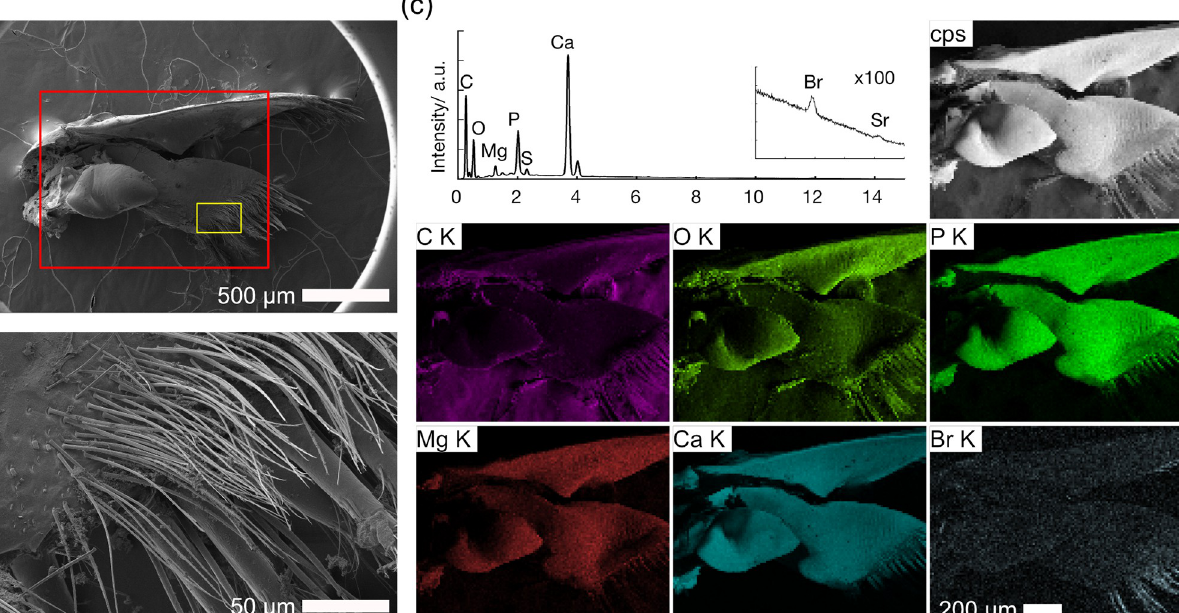
PLOS ONE | https://doi.org/10.1371/journal.pone.0272032 August 4,